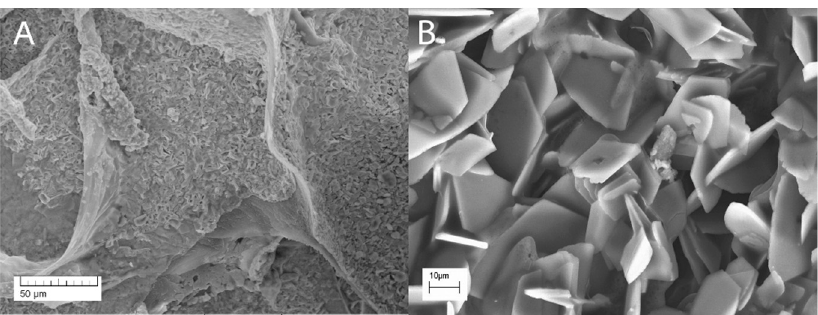
Figure 8. Microstructure of the composite PVP-HA material (sample 5, Table 1). Magnification: ( A )—200×; ( B )—2000×.